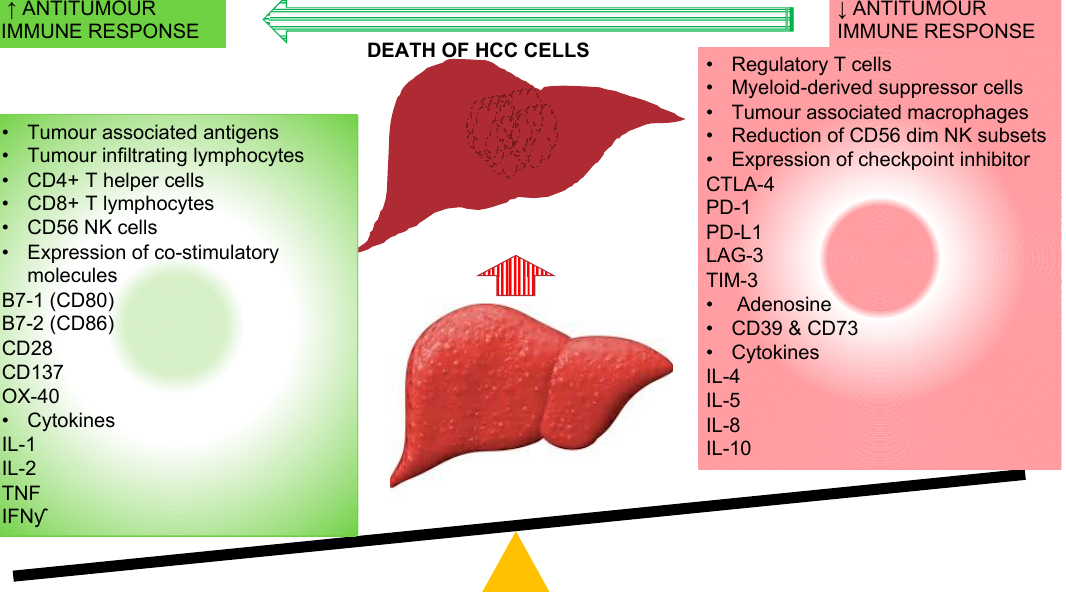
Figure 1. Immunological alteration associated with improved antitumour immune response with the resolution of hepatocellular carcinoma cells. CD: cluster of differentiation; CTLA-4: cytotoxic T-lymphocyte-associated protein-4; IFN γ : interferon-gamma; IL: interleukin; LAG-3: lymphocyte-activation gene 3; PD-1: programmed cell death-1; PD-L1: programmed cell death-ligand1; NK: natural killer cells; TIM-3: T-cell immunoglobulin mucin-3.